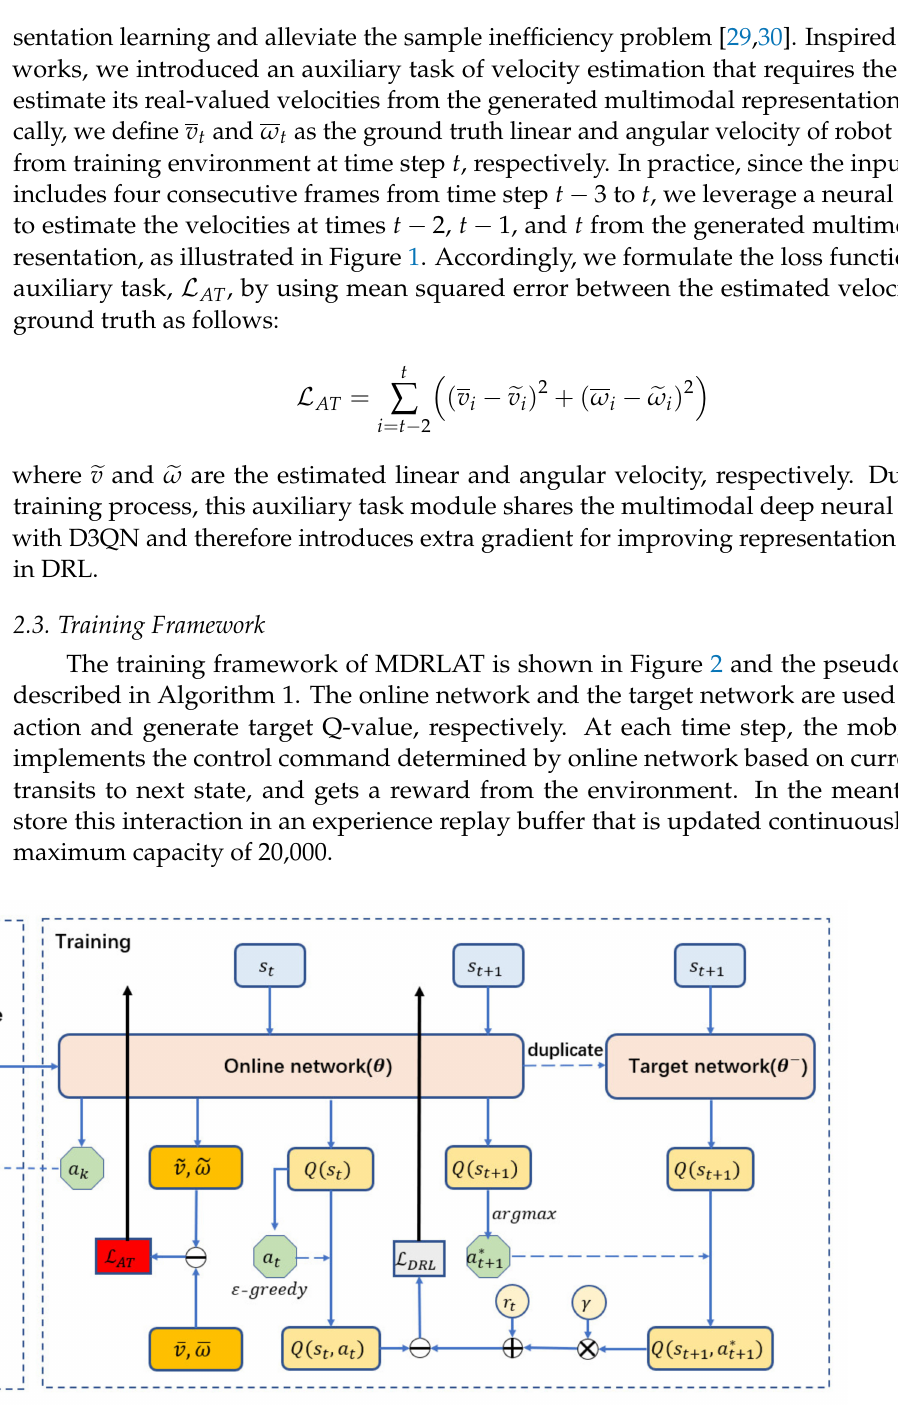
Figure 2. Training framework of the proposed